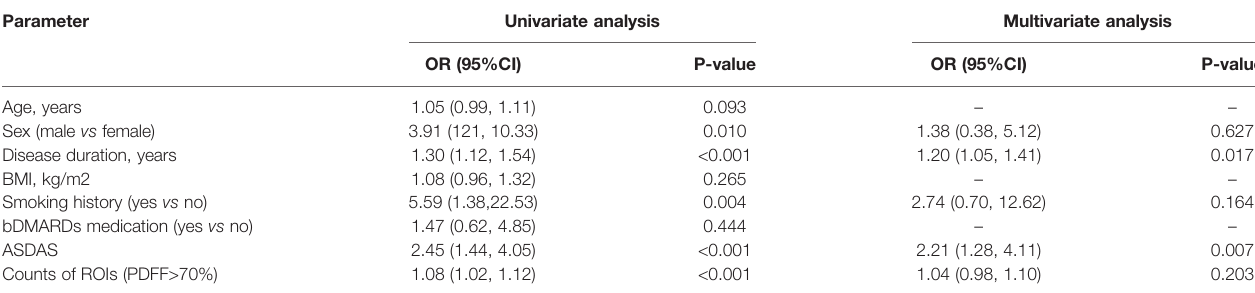
TABLE 8 | Logistic regression analysis for the association between ful fi lling the modi fi ed New York criteria and clinical predictors.